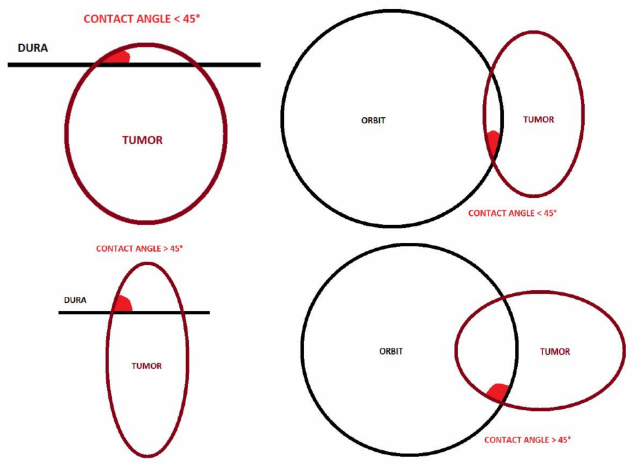
Figure A1. Assessment of contact angle of ≤ 45 ◦ or >45 ◦ between the tumor and dura or